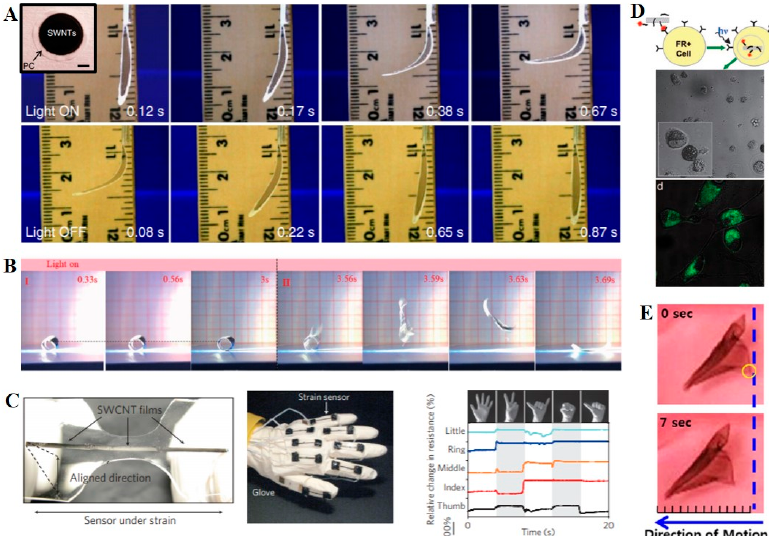
Figure 2. ( A ) Light responsive actuation of bilayers composed of polycarbonate (PC) and HiPCO nanotubes. Reproduced with permission [43], copyright 2014, Nature Publishing Group. ( B ) Light- responsive soft jumping robots composed of rolled carbon nanotube (CNT) and polymer